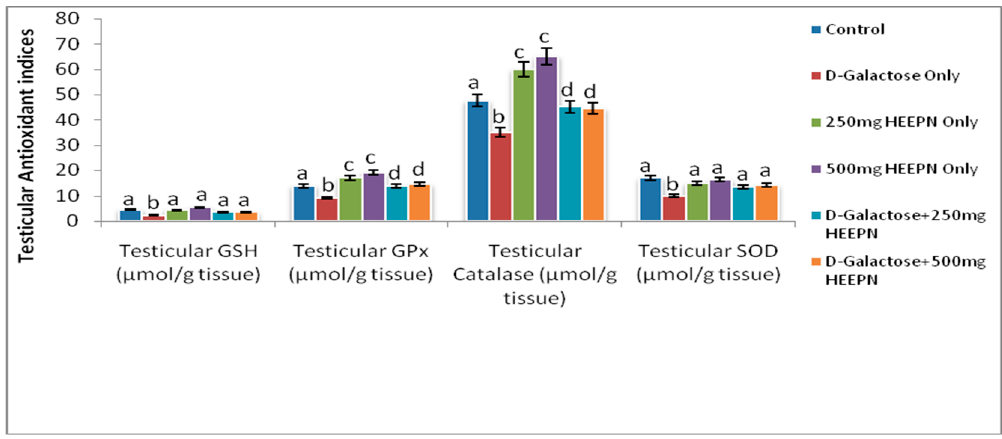
Figure 4. Effect of graded doses of HELEPN on antioxidant indices.Values are means of five replicates ± SEM. Bars carrying different superscripts (a–d) are significantly different at p < 0.05.